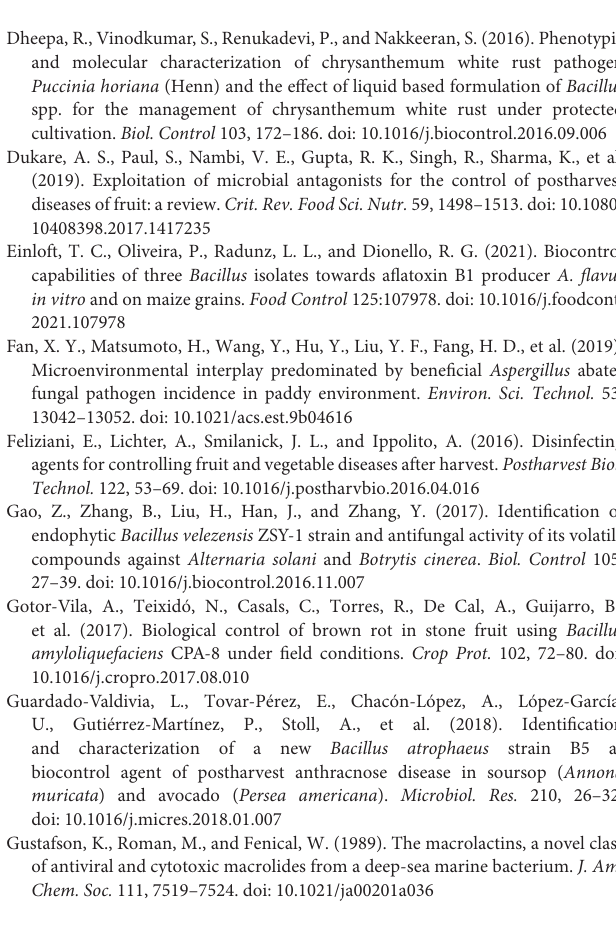
Supplementary Table 3 | Carbon source utilization and nitrogen source utilization of strain QN1NO-4. Supplementary Table 4 | Sensitivity of strain QN1NO-4 to antibiotics. Supplementary Table 5 | Results of average nucleotide identity